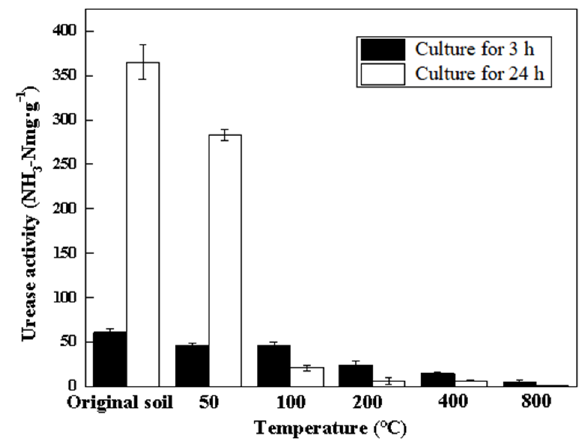
Figure 7. Influence of temperature on soil enzyme sensitivity.